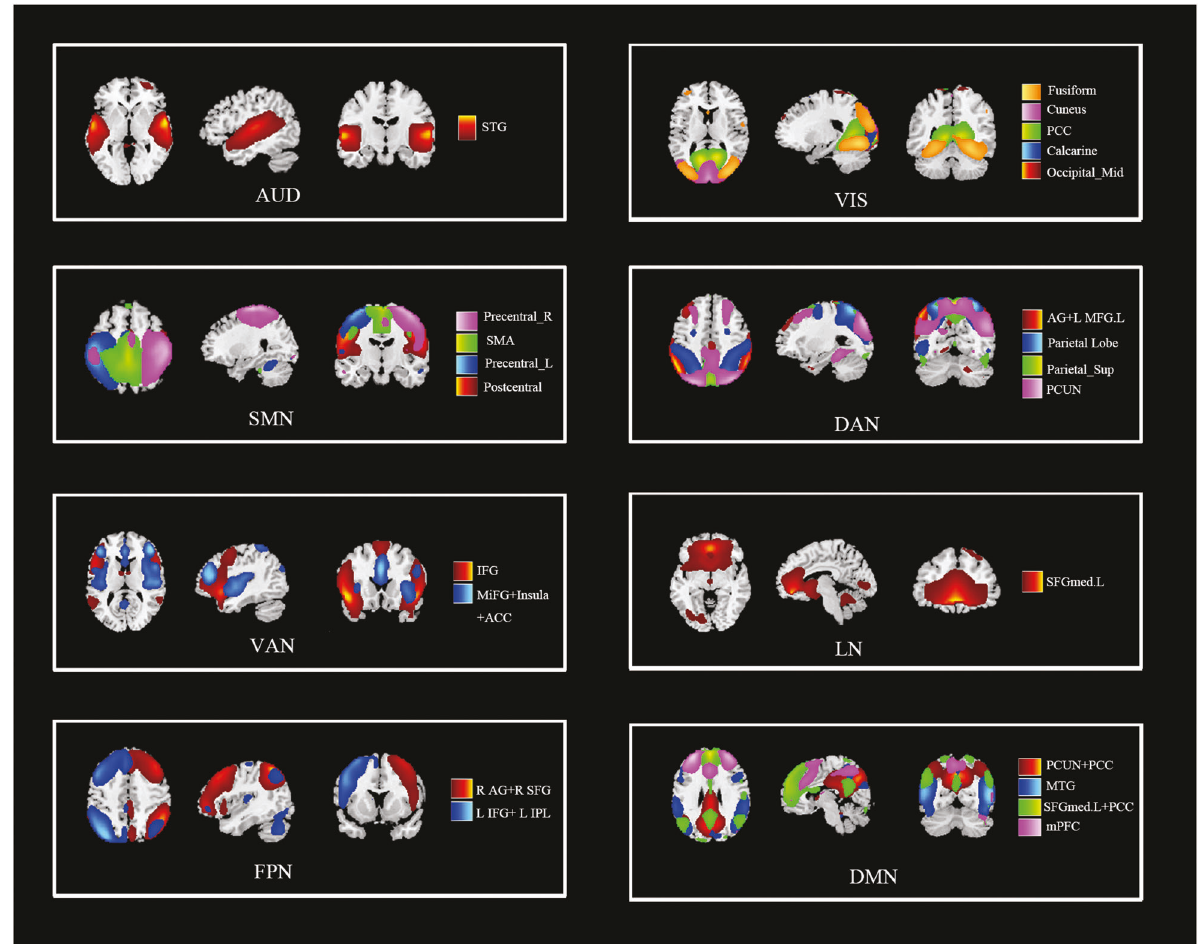
Fig. 1 Spatial maps of 23 independent components sorted into eight intrinsic networks overlaid on the Montreal Neurological Institute (MNI) template. Color bar represents the independent component (IC). AUD auditory network, VIS visual network, SMN somatomotor network, DAN dorsal attention network, VAN ventral attention network, LN limbic network, FPN frontoparietal network, DMN default mode network, L left, R right, STG superior temporal gyrus, Fusiform, fusiform gyrus, Cuneus cuneus cortex, PCC posterior cingulate cortex, Calcarine calcarine cortex, Occipital_Mid middle occipital gyrus, Postcentral postcentral gyrus, Precentral precentral gyrus, SMA supplementary motor area, AG angular gyrus, MFG middle frontal gyrus, Parietal_Sup superior parietal gyrus, PCUN precuneus, IFG inferior frontal gyrus, MiFG middle inferior frontal gyrus, lnsula insular cortex ACC anterior cingulate cortex, SFGmed superior frontal gyrus, medial, SFG superior frontal gyrus, IPL inferior parietal lobule, MTG middle temporal gyrus, mPFC medial prefrontal